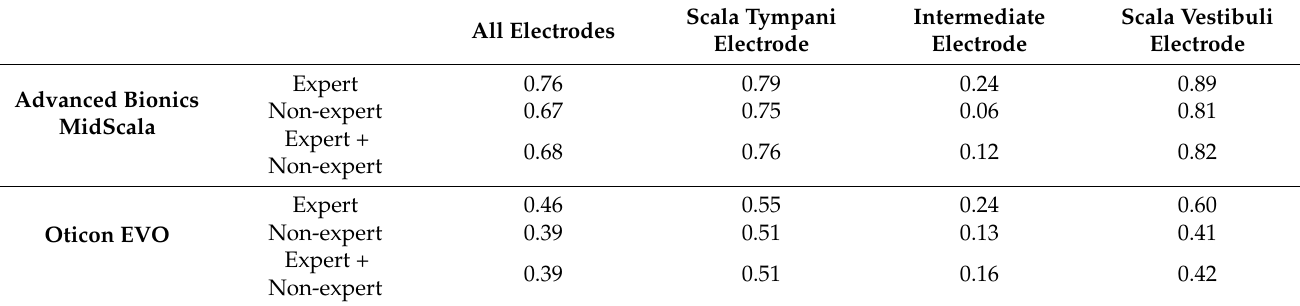
Table 2. Agreement of the five surgeons (two experts and three non-experts) in determining the position of each electrode based on histology. All results are expressed as Fleiss’ kappa, with a target alpha of